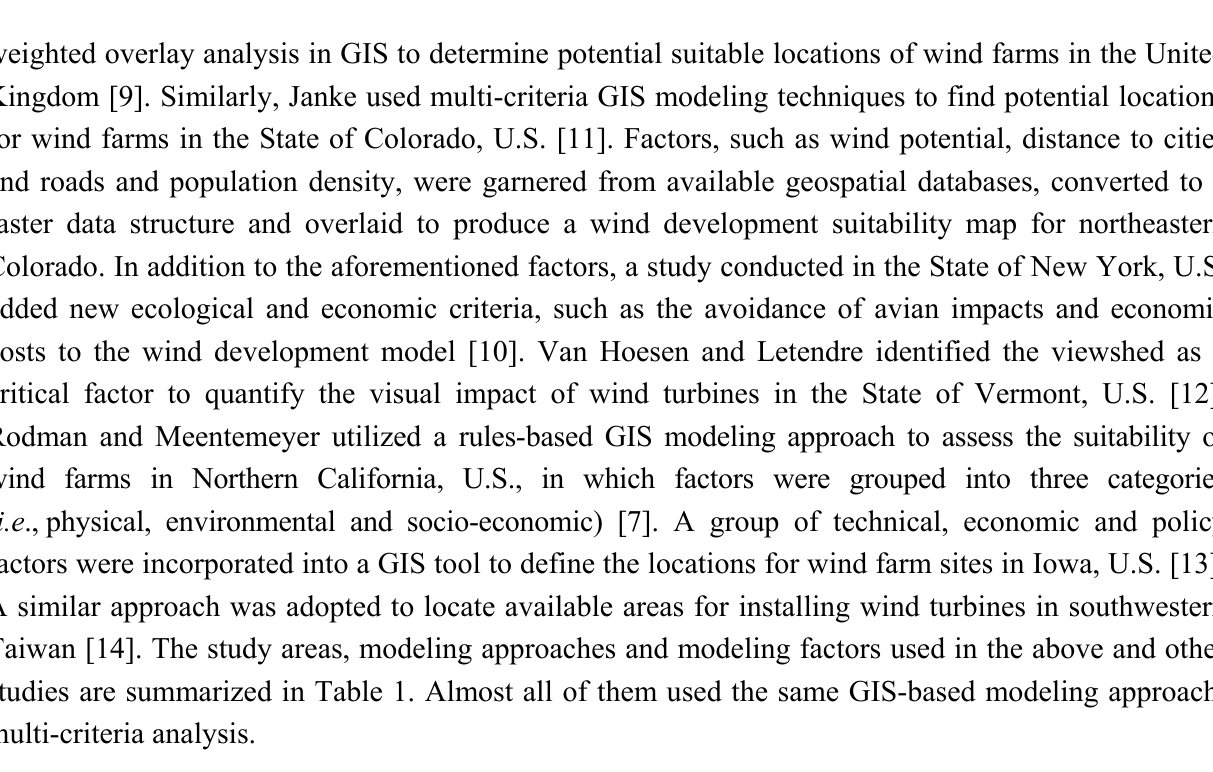
Table 1. Study areas, modeling approaches and factors adopted by studies on land suitability for wind energy